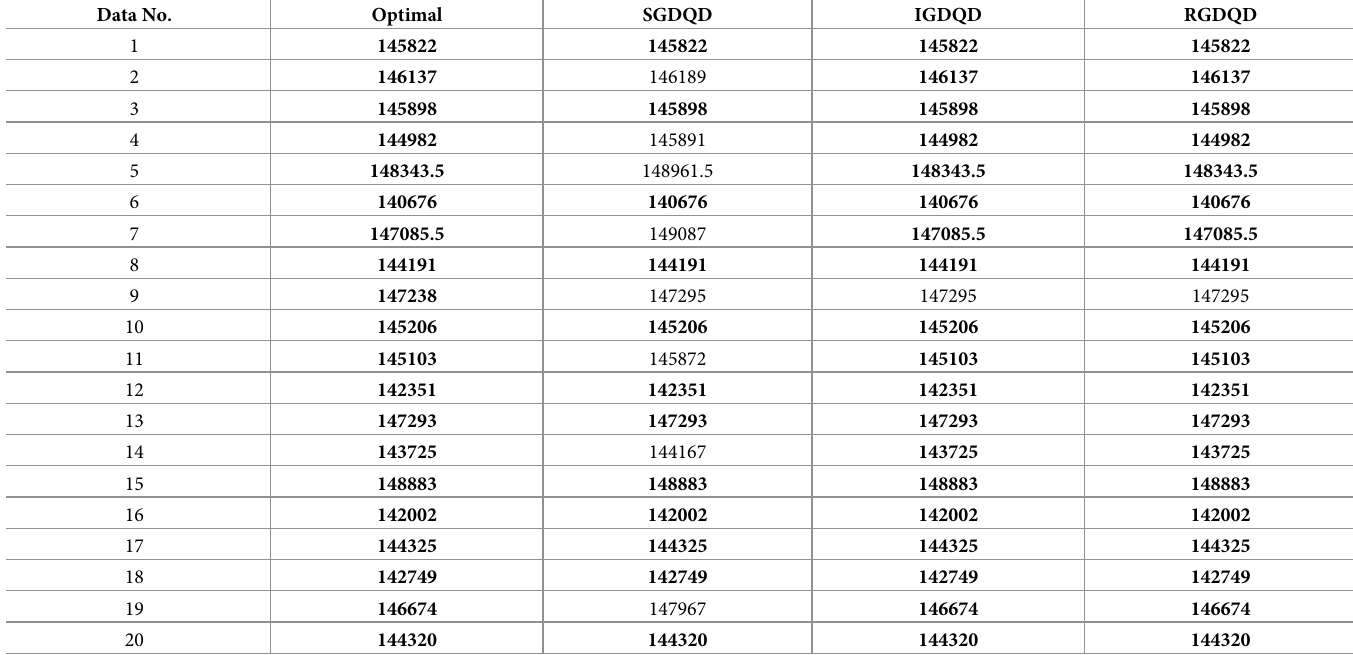
Table 8. Solutions for Q = 15000. Data No.